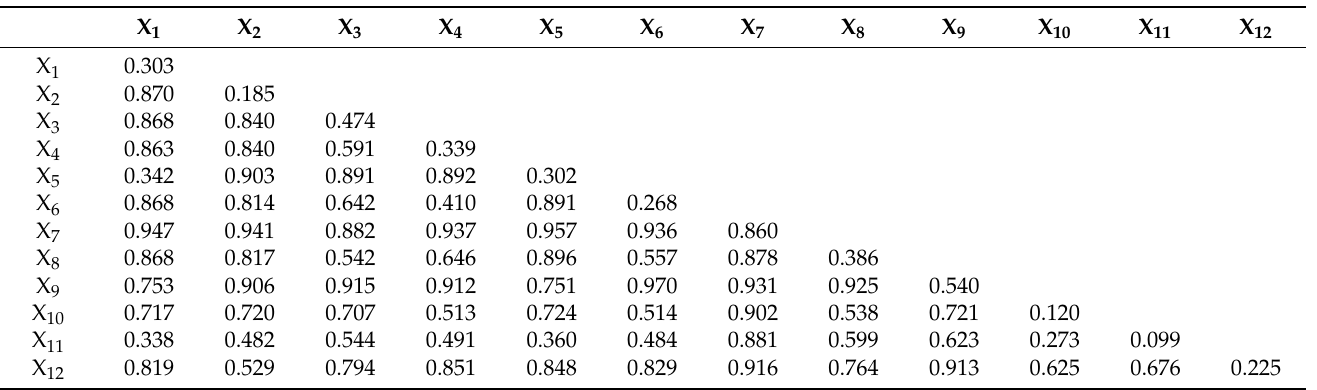
Table 4. Interaction of detection